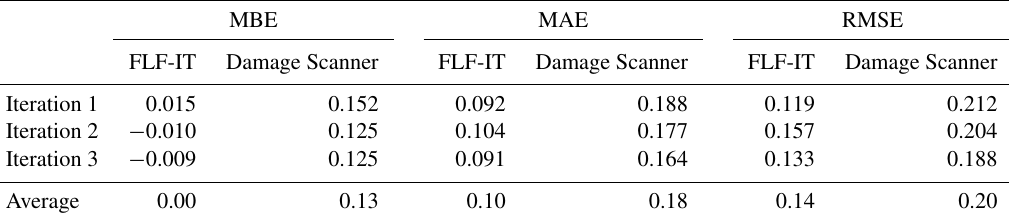
Table 2. Error estimation for the performance of the FLF-IT model (MBE: mean bias error; MAE: mean absolute error; RMSE: root mean square error). MBE MAE RMSE FLF-IT Damage Scanner FLF-IT Damage Scanner FLF-IT Damage Scanner Iteration 1 0.015